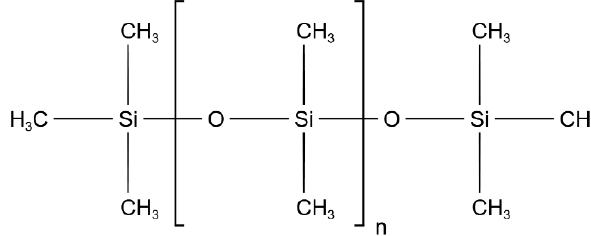
Figure 2. The formula of polydimethylsiloxane.